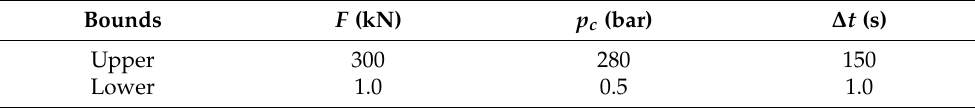
Table 3. Values of Variables used for GG and SC cycles.